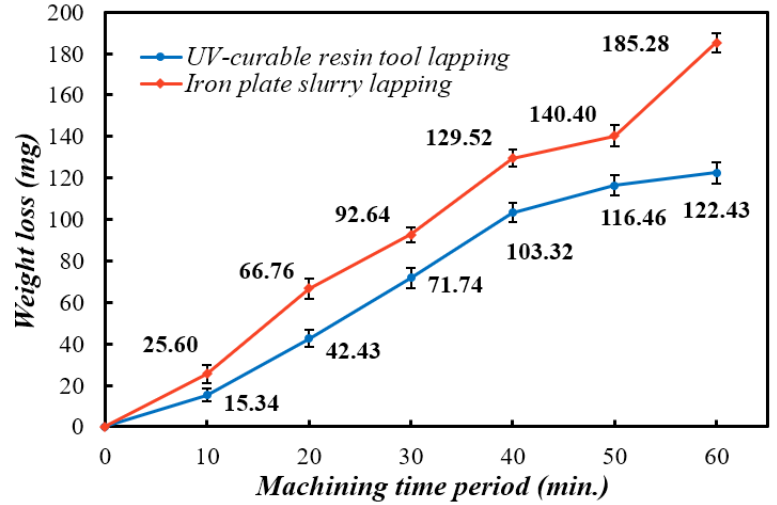
Figure 6. Periodical weight loss of the workpieces.